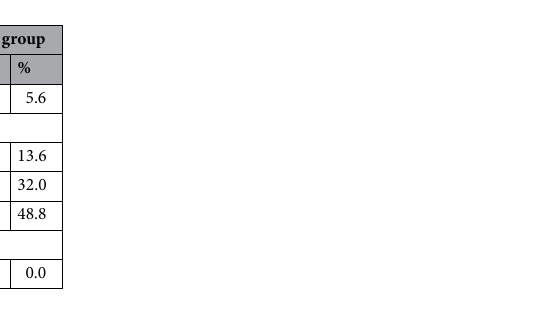
Table 3. VDSL: vitamin D serum